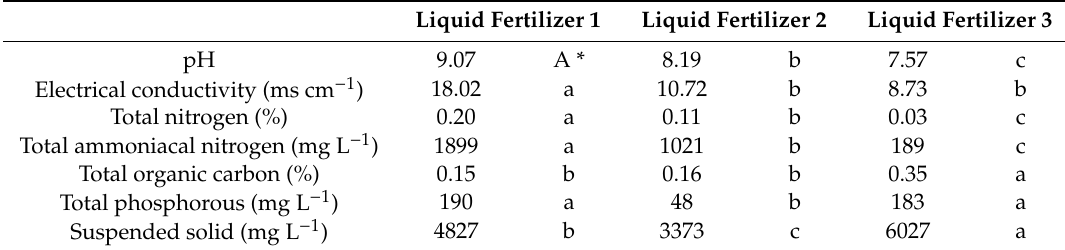
Table 1. Basic properties of liquid fertilizers.